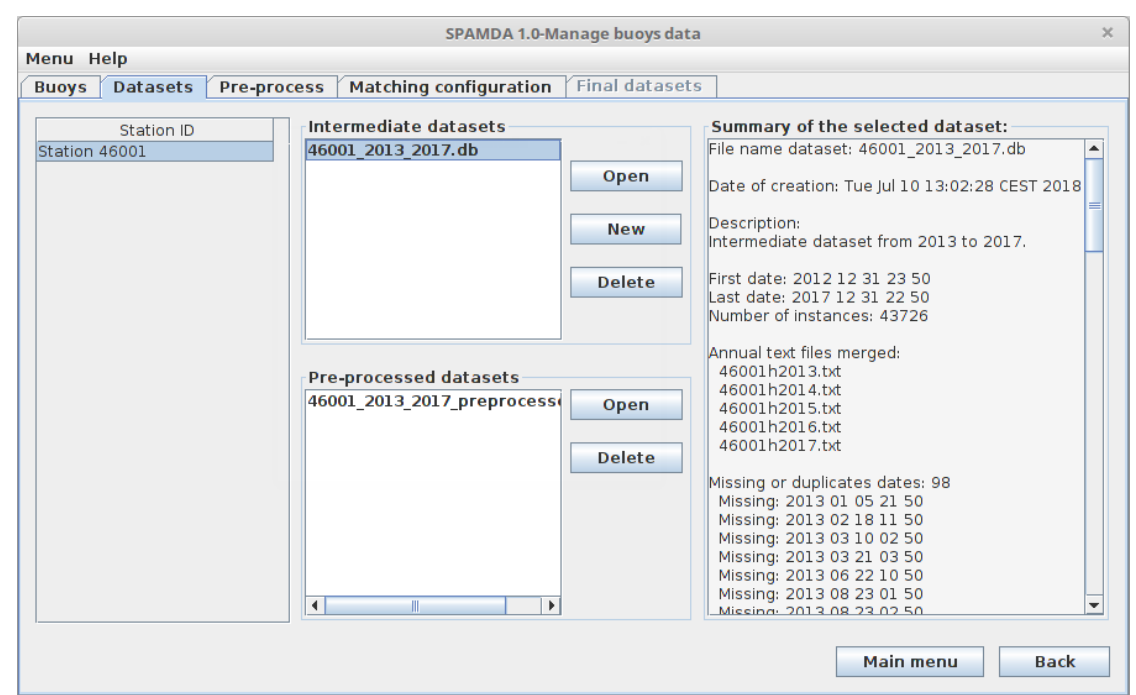
Figure 16. Datasets tab: intermediate datasets of the buoy ID 46001.